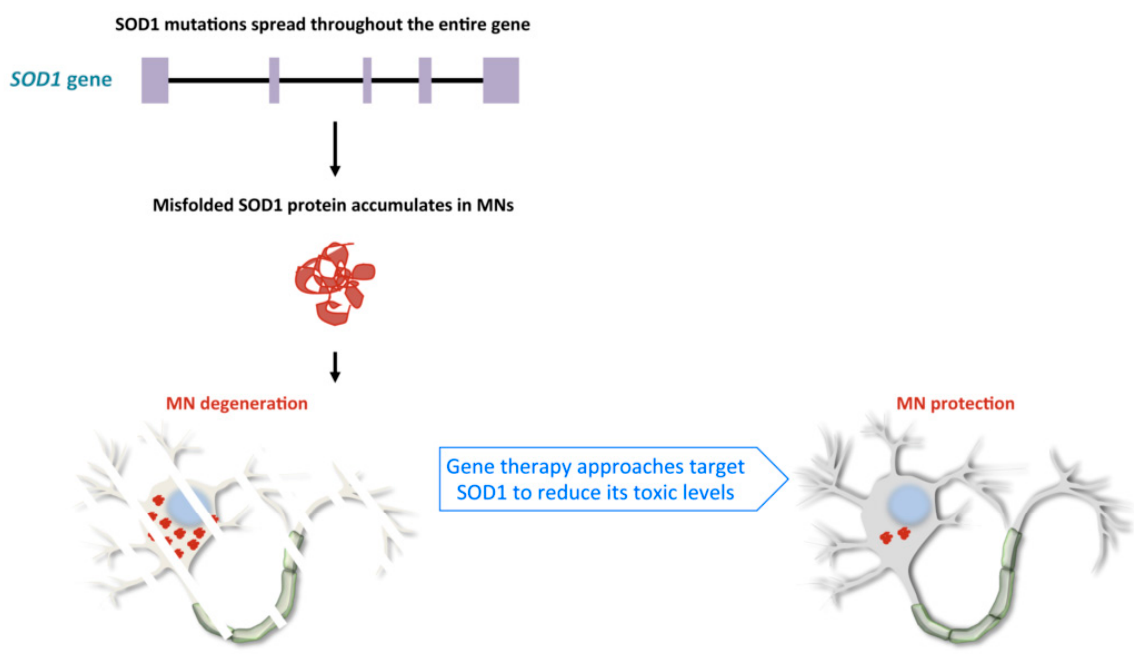
Figure 1. Schematic representation of the human SOD1 gene, the pathological consequences of its mutations and the e ff ects of the gene targeting approach. The majority of mutations in the SOD1 gene induce misfolding of the encoded enzyme. Misfolded protein accumulates in protein aggregates and becomes toxic to motor neurons (MN). Gene therapy approaches aimed at reducing SOD1 toxic levels preserve MN